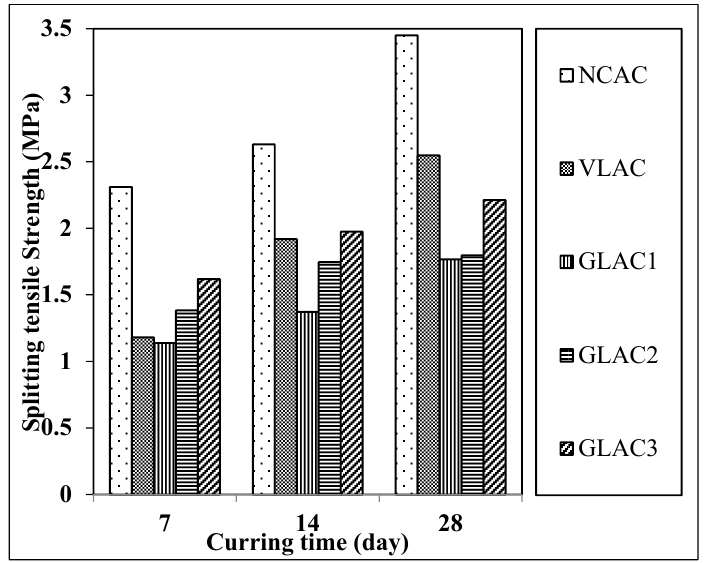
Figure 14. Splitting tensile strength of GLAC, NCAC and VLAC at 7, 14 and 28 days and at W/C of 0.5.